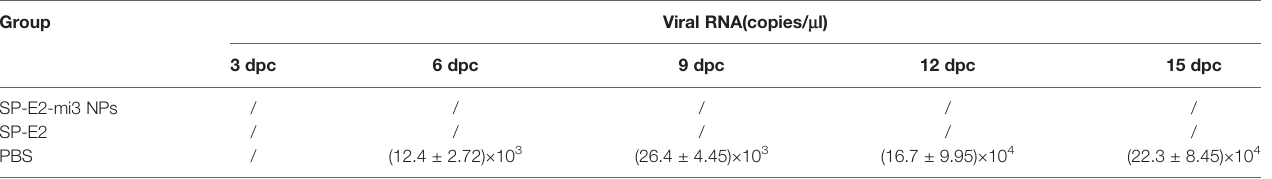
TABLE 1 | Detection of viral RNA in the whole blood samples from the SP-E2-mi3 NPs vaccinated piglets by qPCR. Group Viral RNA(copies/ m